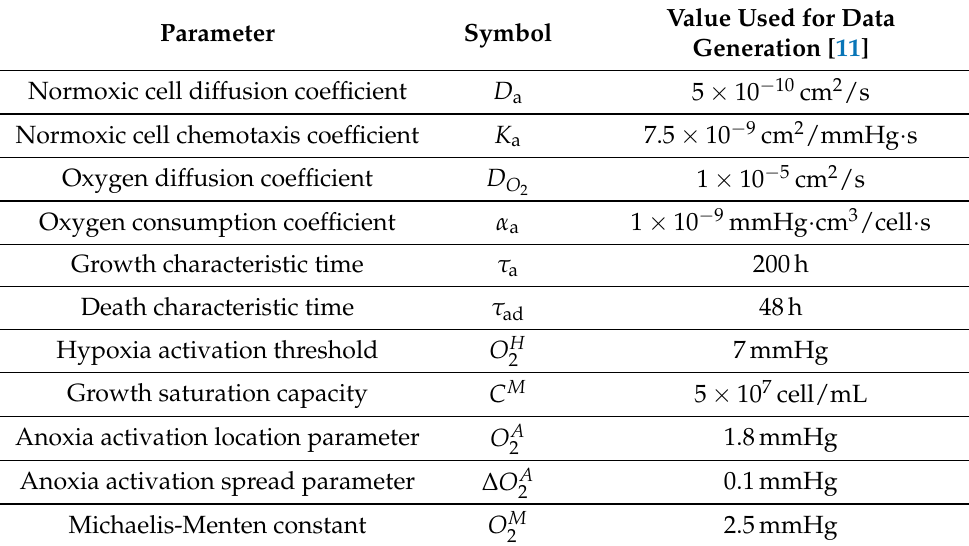
Table 1. Model parameters and values used for data